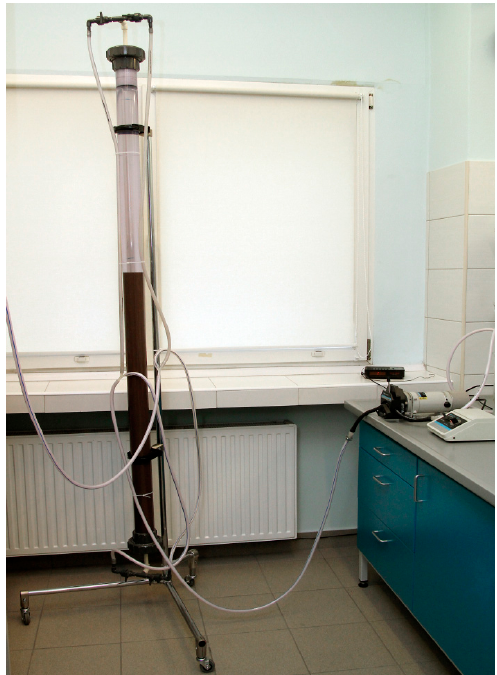
Figure 1. Ion-exchange column for the production of Ni(ReO 4 ) 2 .